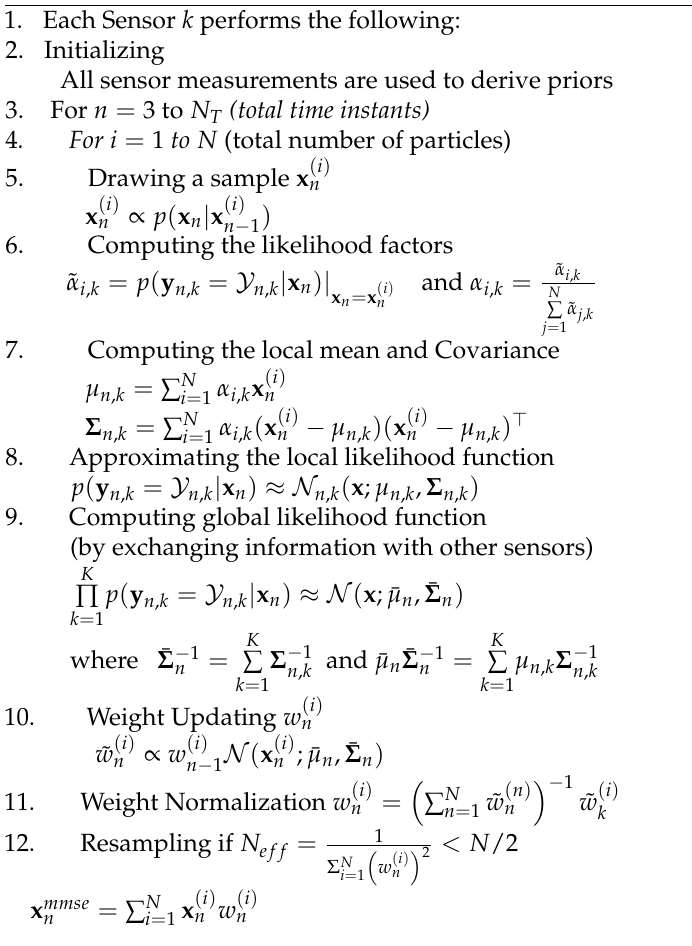
Algorithm 3 Distributed particle filtering